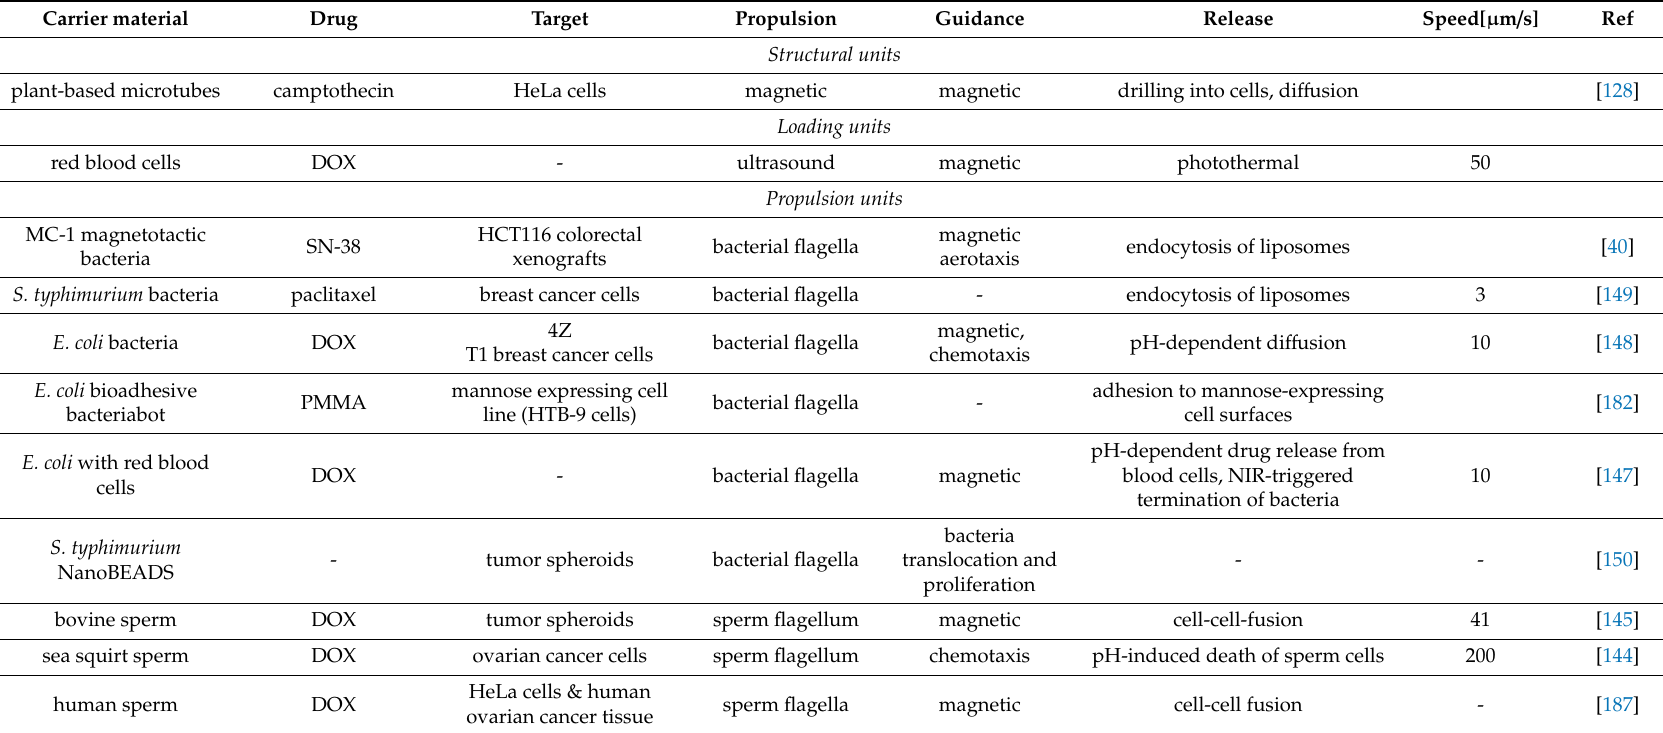
Table 3. List of biohybrid nano-and micromotors for cancer